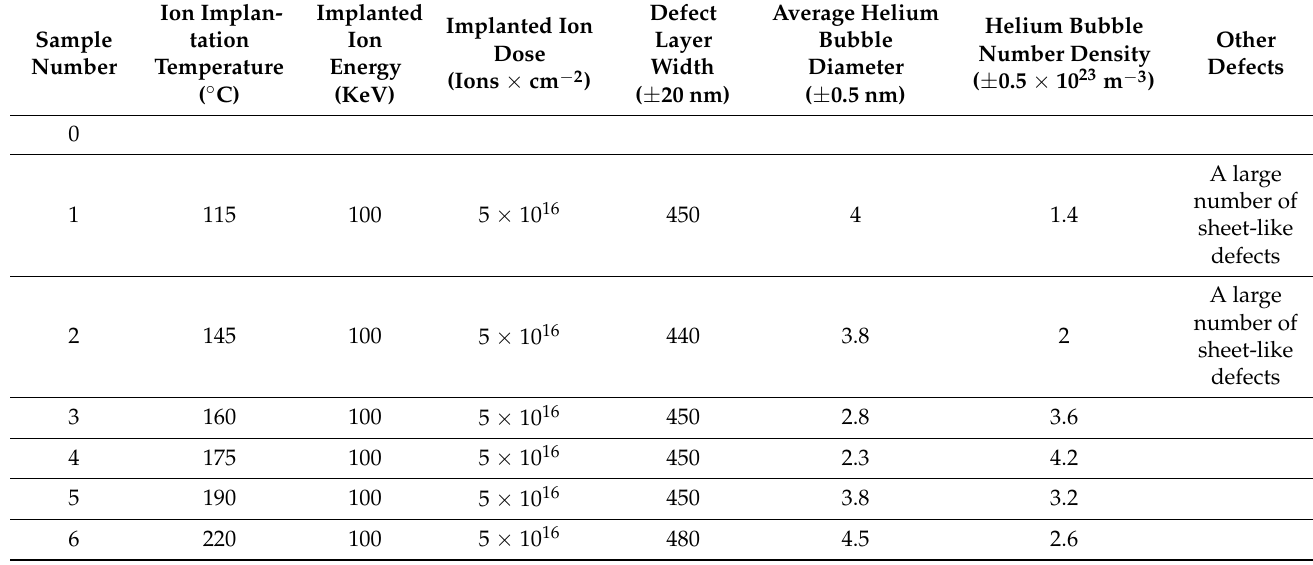
Table 1. Helium bubble growth under different helium ion